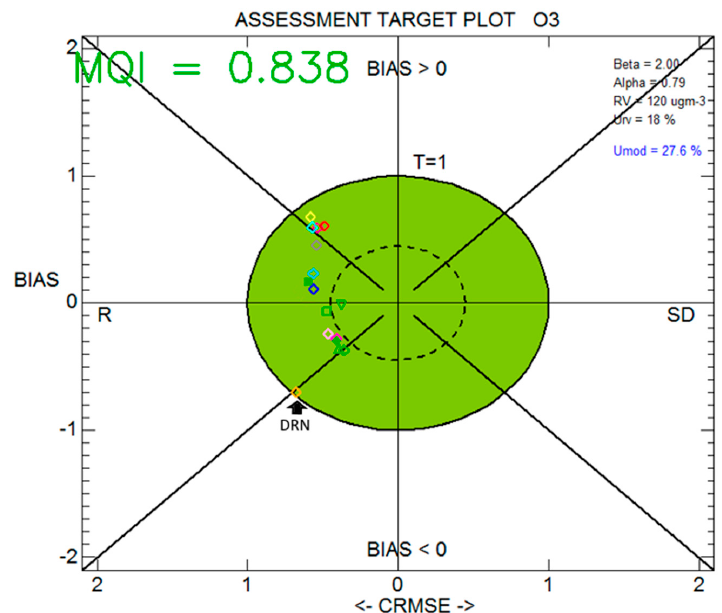
Figure 6. Target plot for the maximum daily 8-h mean values of ozone in the summer, obtained with the Delta Tool. The uncertainty parameters (Alpha, Beta, Reference Value (RV) and U rv) used to produce the diagram are listed on the top right-hand side together with the associated model uncertainty calculated by the DELTA software.